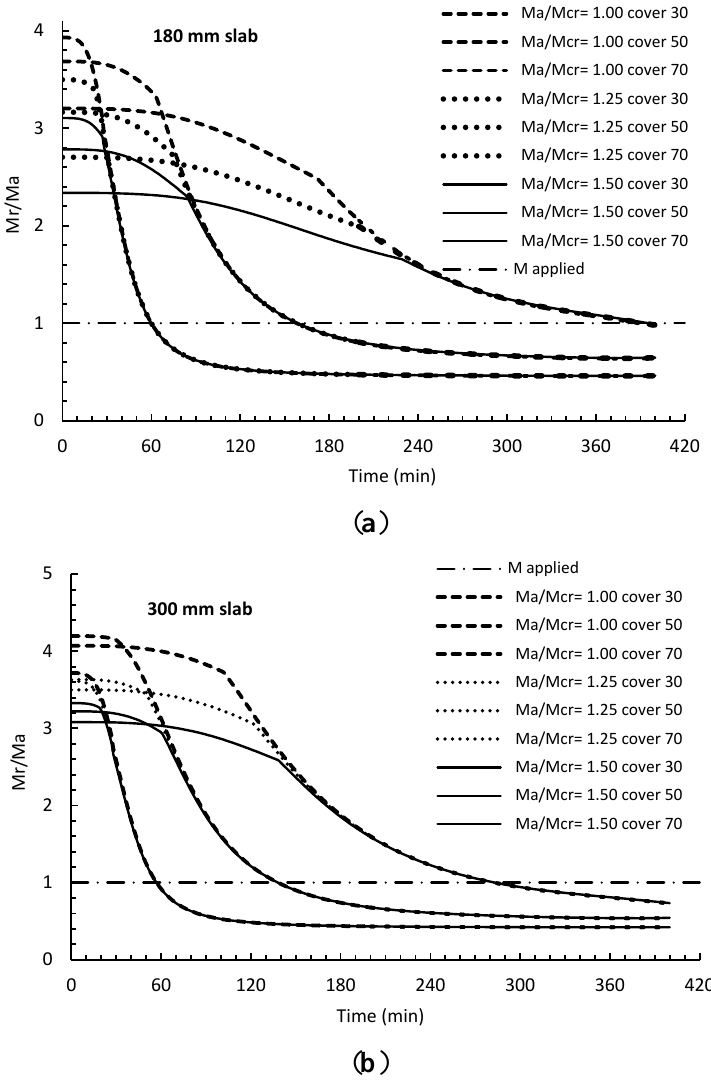
/ M in fire for various concrete covers for: ( a ) 180 mm and ( b ) 300 r a